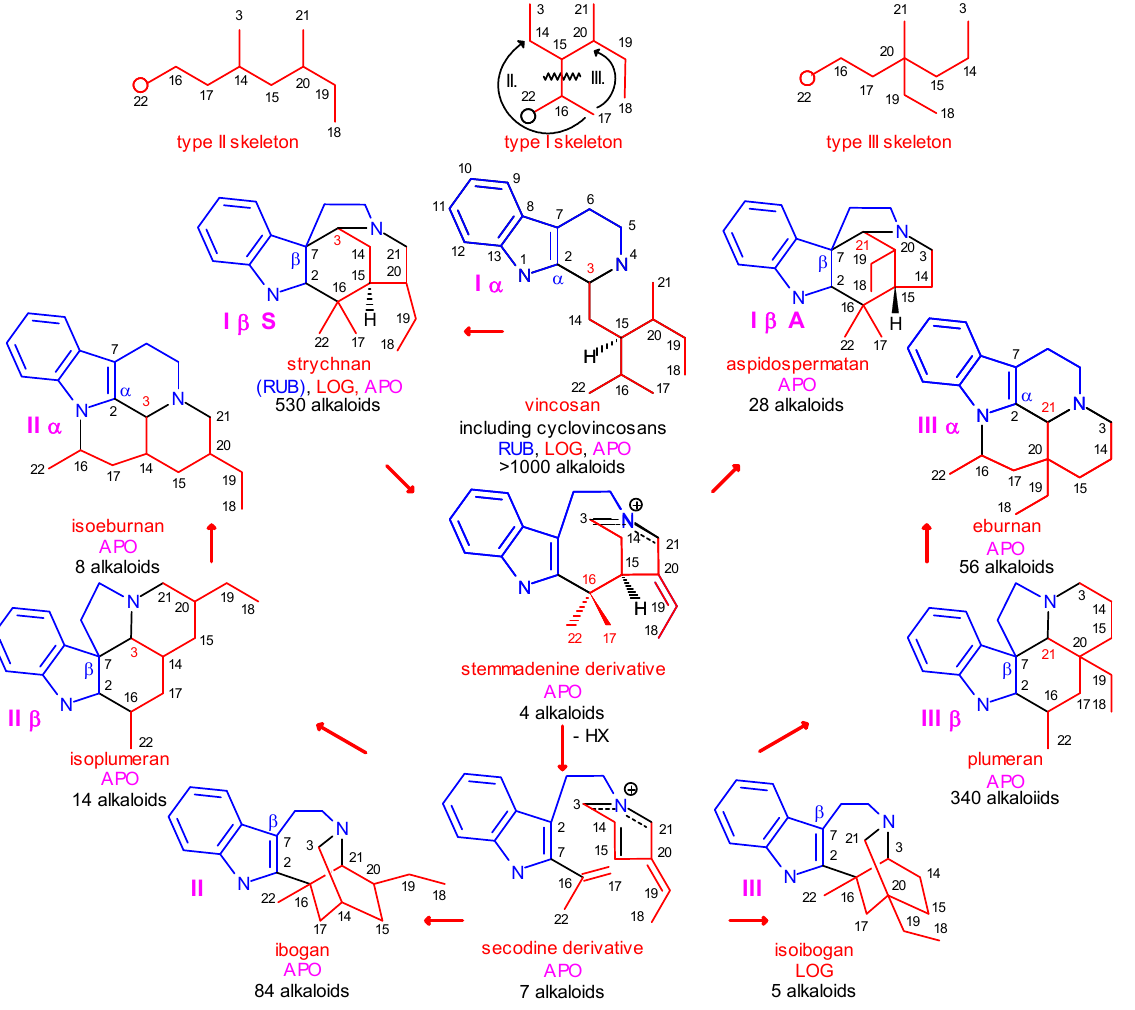
Scheme 2. System of Indole Alkaloids Derived from